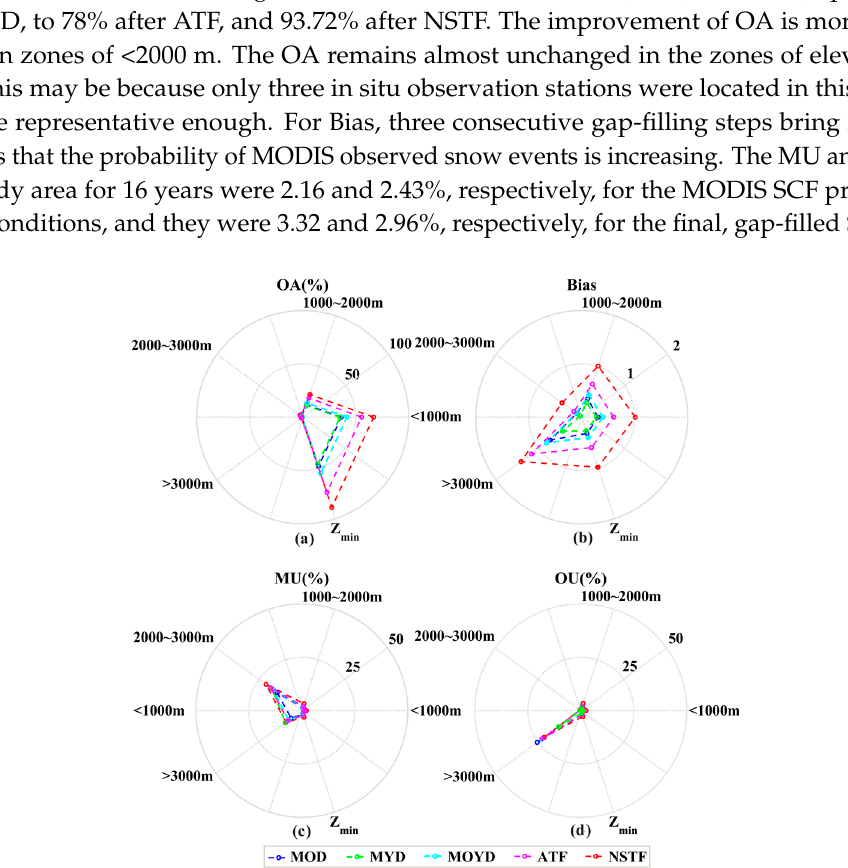
Figure 13. Validation results based on in situ SD observations in different elevation zones.